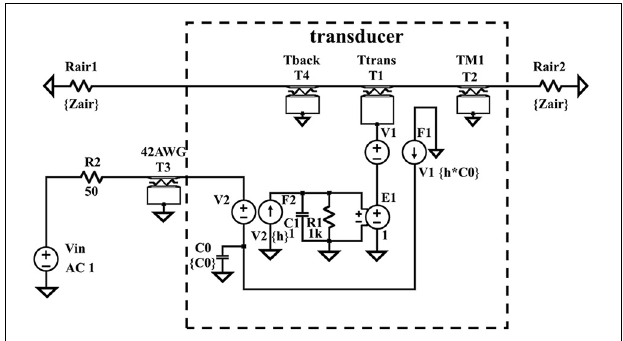
FIGURE 6 | The equivalent circuit simulation diagram by using LTspice software.